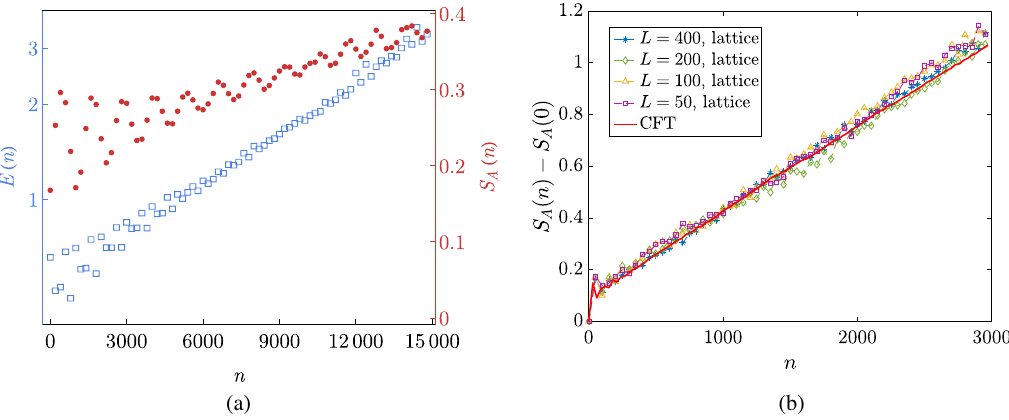
FIG. 10. The total energy and entanglement entropy of the subsystem A ¼ ½ 0 ; L= 2 (cid:2) with random driving. (a) We choose L ¼ 2 π , and ¯ T ¯ T ¯ T ¯ T=L , ¼ 0 . 1 , and α ¼ 0 . 01 . n is the number of driving cycles. Each data point is calculated by doing a random average 0 ¼ 1 ¼ 1000 times. The energy (blue hollow squares) grows with time exponentially. The entanglement entropy (red dots) for the left half system grows with time linearly. (b) Entanglement entropy evolution for subsystem A ¼ ½ 0 ; L= 2 (cid:2) with different L . The lattice calculation 200 , with L ¼ 50 , 100, 200, and 400, respectively. The randomness is done with complex free fermions and is averaged over N sample ¼ ¯ T ¯ T ¯ T=L ¯ T , is chosen as ¼ 0 . 03 , and α ¼ 0 . 06 0 ¼ 1 ¼